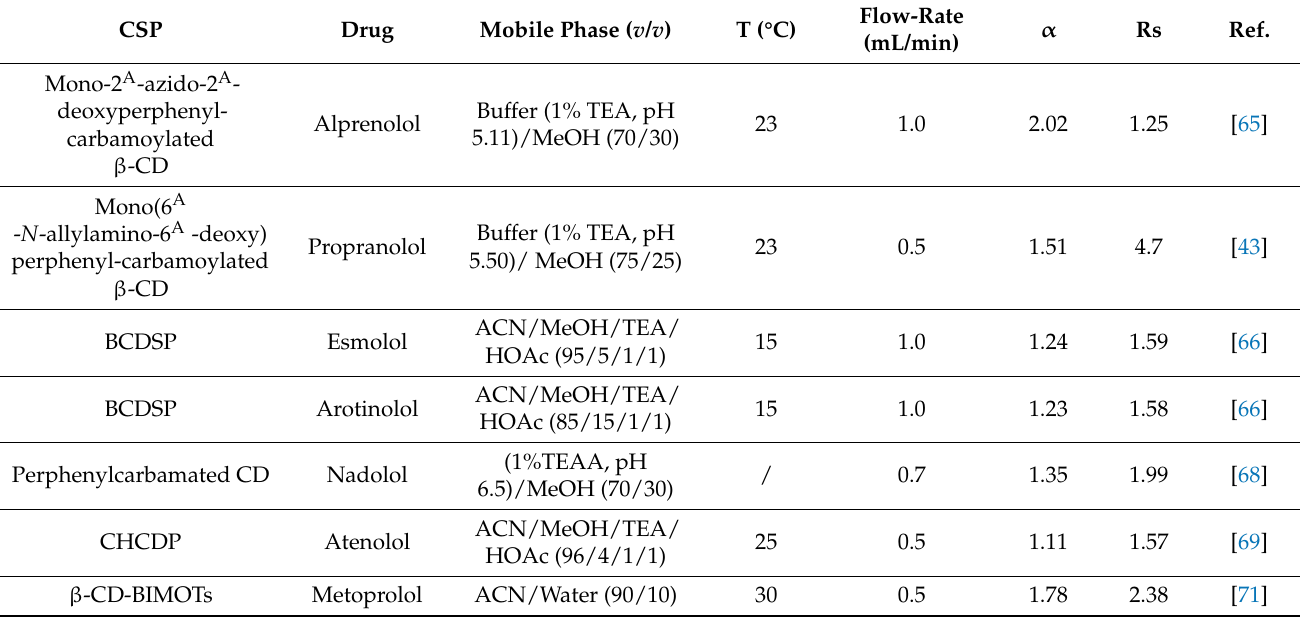
Table 5. Typical results for the enantioseparation of the β -blockers with cyclodextrin based CSPs. CSP Drug Mobile Phase ( v / v